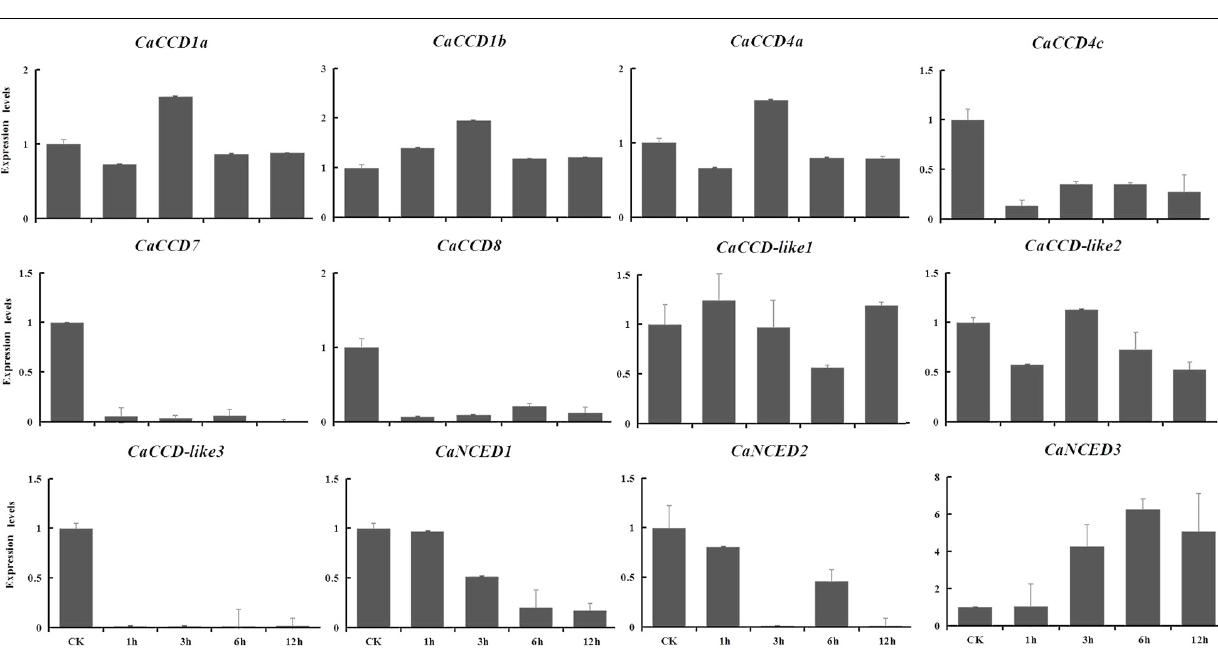
continuously as byproducts of various metabolic pathways that are localized in different cellular compartments including mitochondria, chloroplast, and peroxisomes (del Río et al., 2006; Navrot et al., 2007). Under stable conditions, ROS can be removed and maintained in equilibrium utilizing antioxidants or